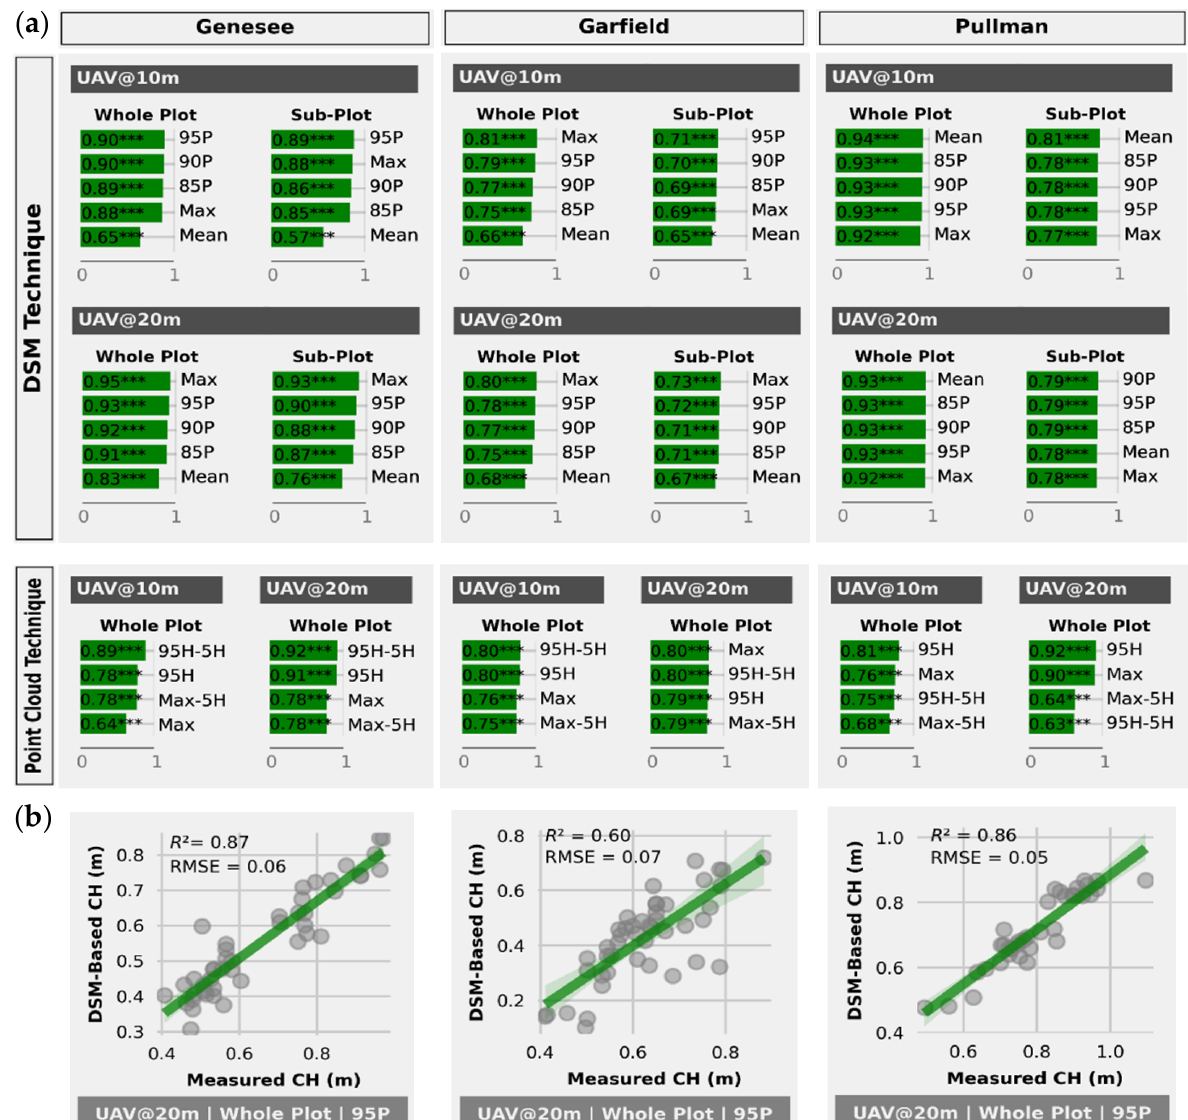
Figure 5. Relationships between ground reference data and digital canopy height traits (at F50 stage) extracted from UAV imagery from three trials at Genesee, Garfield, and Pullman: ( a ) correlation coefficients based on digital traits extracted from DSM and point cloud data; ( b ) linear regression between DSM-based 95th-percentile CH and ground reference data. CH : canopy height; DSM technique —Max: maximum CH; 95P: 95th-percentile CH; 90P: 90th-percentile CH; 85P: 85th-percentile CH; Mean: average CH; Point cloud technique —Max: CH at maximum height; 95H: CH at 95% percentile height; Max-5H: CH difference between the maximum and 5% height; 95H-5H: CH difference between 95% and 5% height. Significant probability level: *** 0.001.